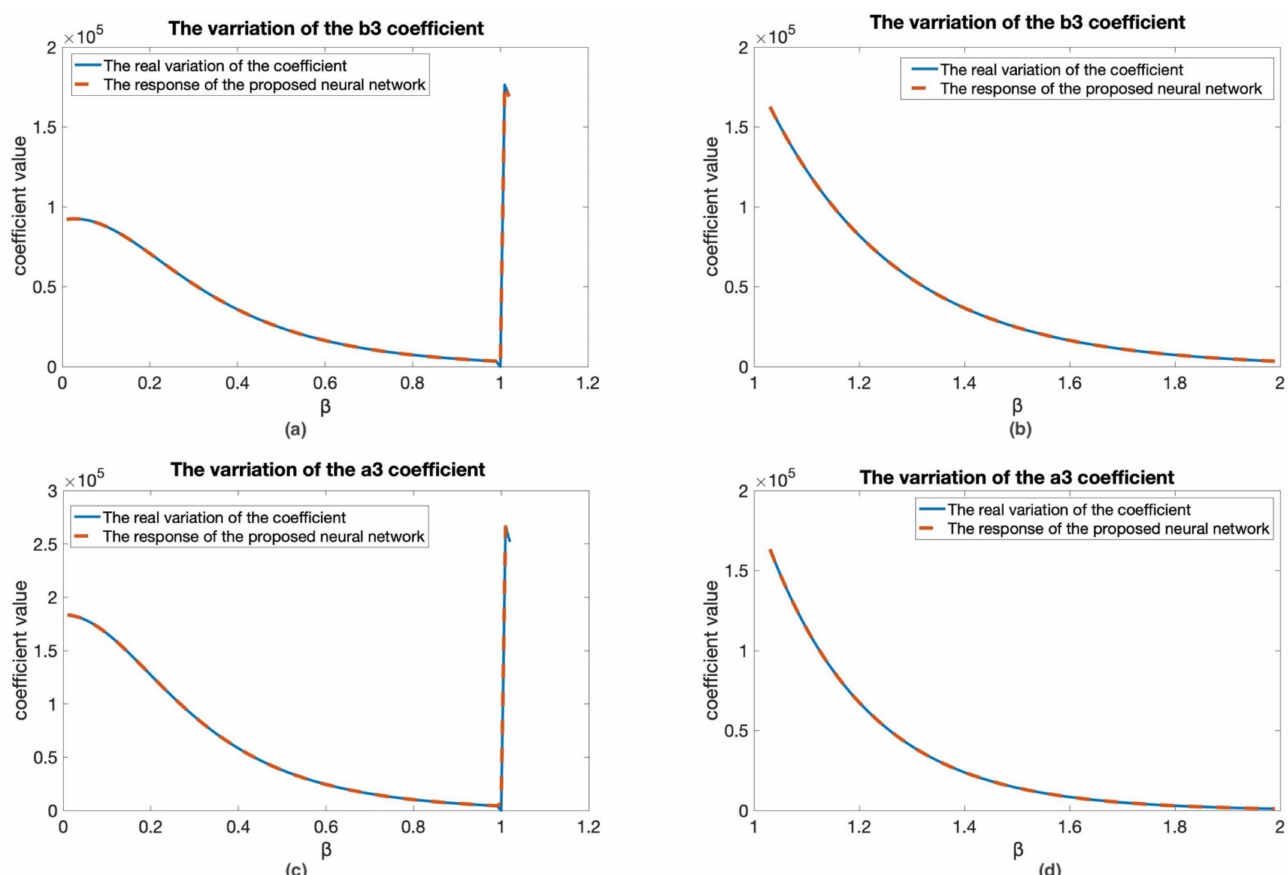
Figure A1. Proof of the proposed neural networks accuracy: ( a ) The evolution of the transfer function b 3 coefficient in relation to β ( β (cid:101) ( 0; 1.02 ] ) and the response of the proposed neural network; ( b ) The evolution of the transfer function b 3 coefficient in relation to β ( β (cid:101) ( 1.02, 1.99 ] ) and the response of the proposed neural network; ( c ) The evolution of the transfer function a 3 coefficient in relation to β ( β (cid:101) ( 0; 1.02 ] ) and the response of the proposed neural network; ( d ) The evolution of the transfer function a 3 coefficient in relation to β ( β (cid:101) ( 1.02, 1.99 ] ) and the response of the proposed neural